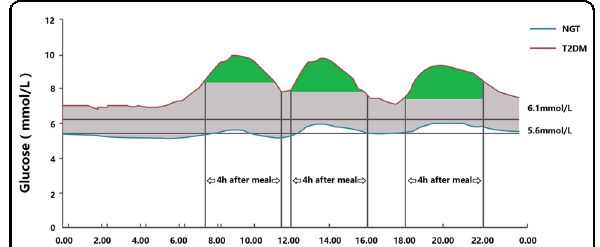
Fig. 1 Calculationused for the AUC under condition A. The green part represents AUC- PPG . The gray partrepresents AUC-BG (AUC-T – AUC- PPG).